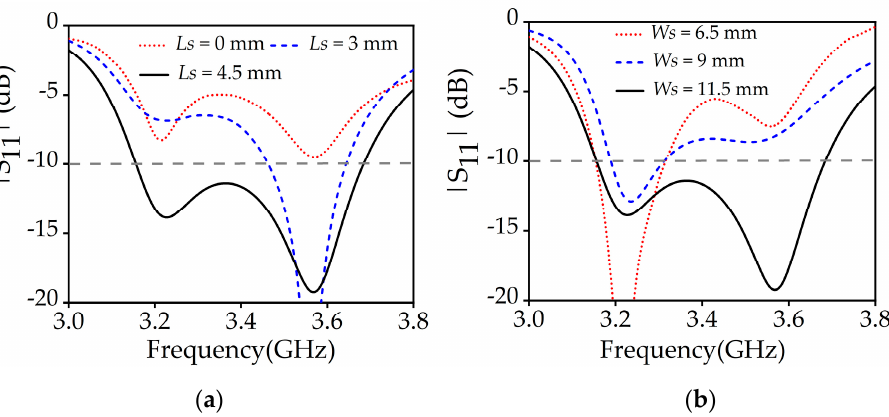
Figure 6. Simulated |S 11 |s under ( a ) different lengths of Ls , and ( b ) different lengths of Ws of